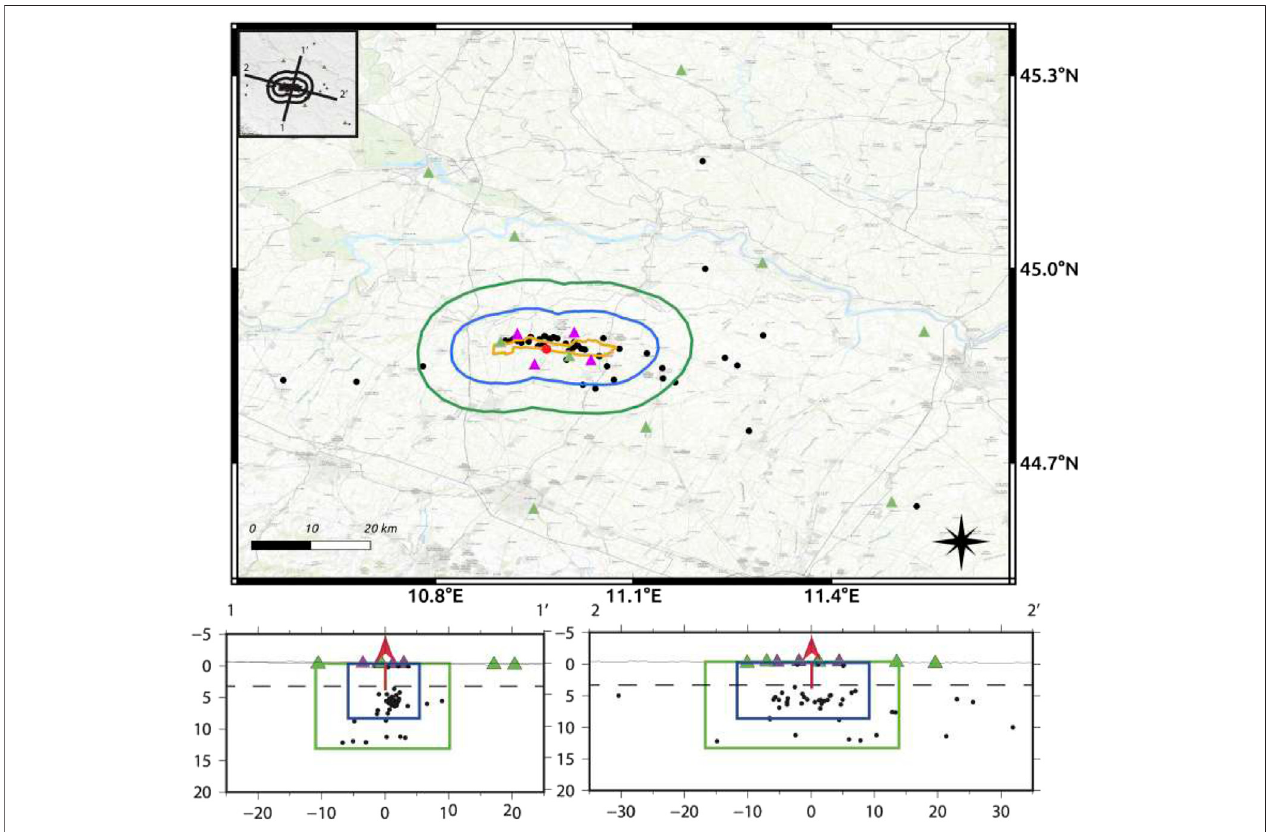
FIGURE 6 | Map of the seismicity (black dots) recorded and localised during 2018 – 2019 monitoring period. The local seismic station (VO network) and Italian Seismic Network station (IV network) locations are also showed as purple and green triangles respectively. The red dot in the map corresponds to the red arrow in the sections belowandindicates thepositionofthe Cavone14 injectionwell.Theblue andgreencontour linessketchthetwointernalandextendeddomains ofinterest.The yellowpolygon showsthereservoirprojectionatthesurface,whosedepthisapproximatelyonthedashedlineinthetwoverticalsections,whilethesolidlinemarks the topography pro fi